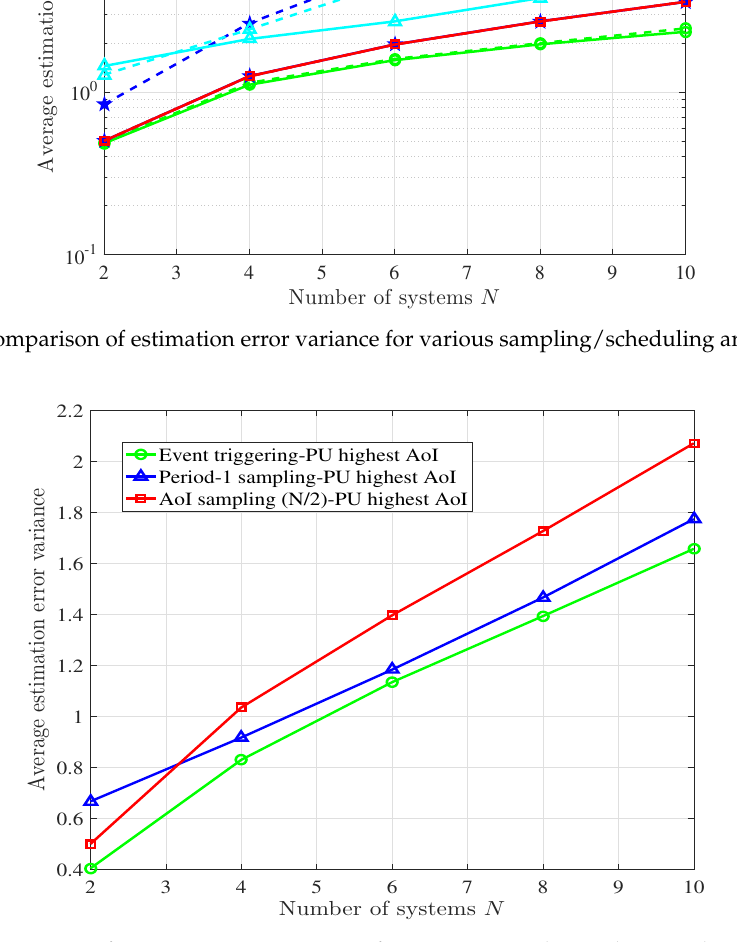
Figure 5. Comparison of estimation error variance for various sampling policies and PU highest AoI scheduling